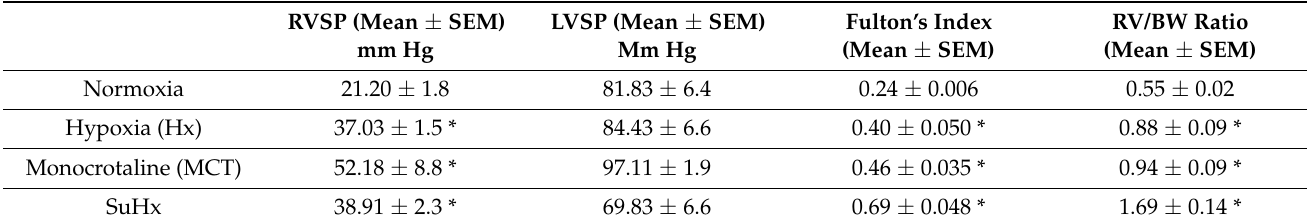
Table 1. Hemodynamic characteristics of experimental pulmonary hypertension. Right Ventricular Systolic Pressure (RVSP), Left Ventricular Systolic Pressure (LVSP), Fulton’s Index (FI).